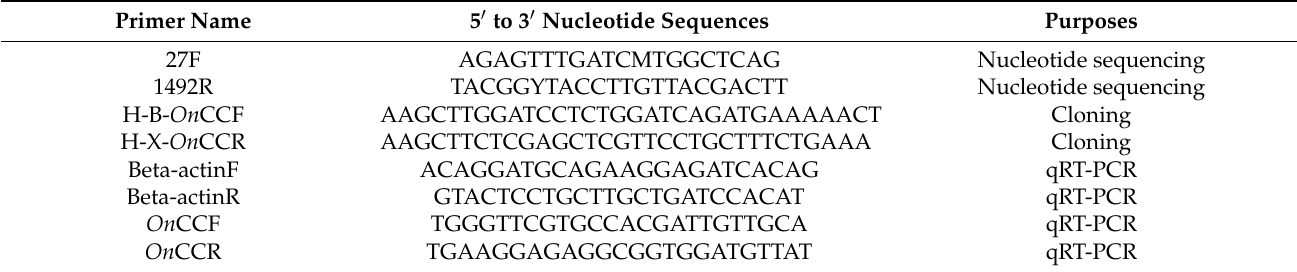
Table 1. Sequences of primers used in this